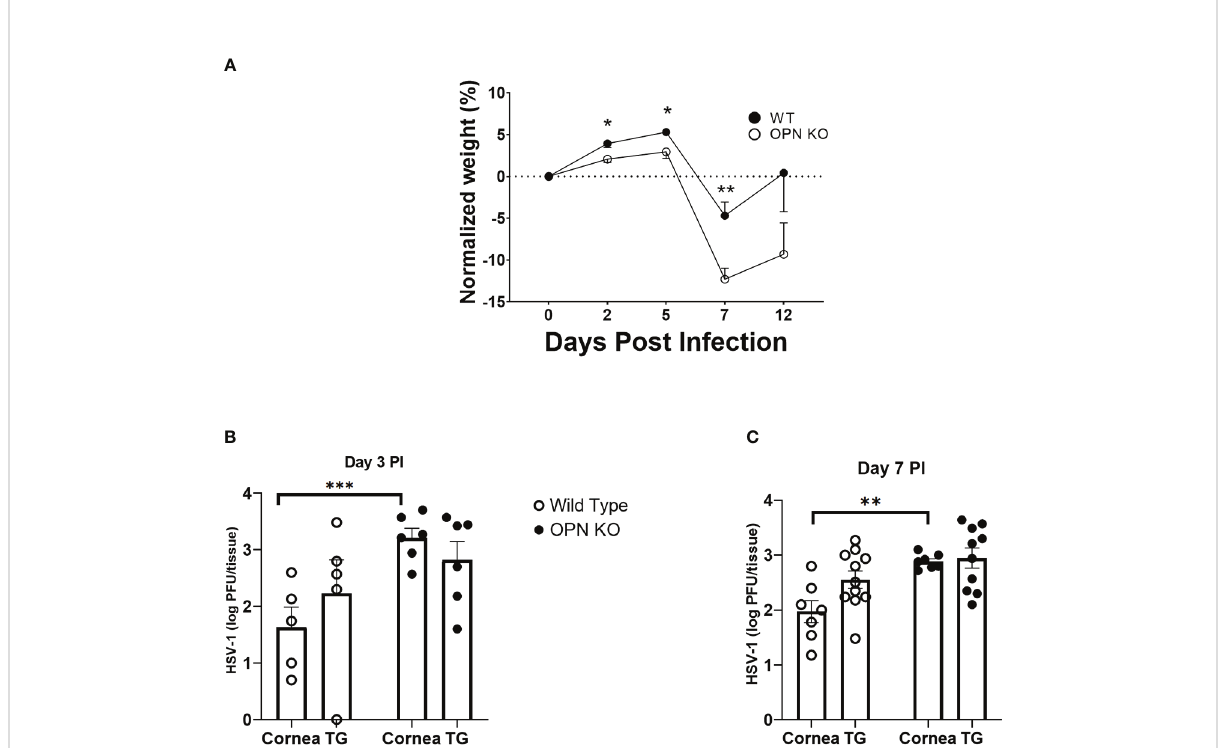
FIGURE 1 HSV-1 replication is not controlled in the cornea of OPN KO mice. C57BL6 (WT) and OPN KO male and female mice were infected with HSV-1 (350 PFU/cornea). (A) At the indicated time PI, the mice (n= 6-24/time point/group) were weighed. The average weight prior to infection (day 0) for WT mice was 22.1 grams and OPN KO mice was 22.4 grams. At day 3 (B) or day 7 (C) PI, WT and OPN KO mice (n=5-10/group/timepoint) were exsanguinated, and the cornea and TG were removed and processed to determine viral titer by standard plaque assay. *p < .05, **p < .01, and ***p < .001 comparing the two groups at the indicated time point as determined by the Holm-Sidak t-test. Results are depicted as the mean ±